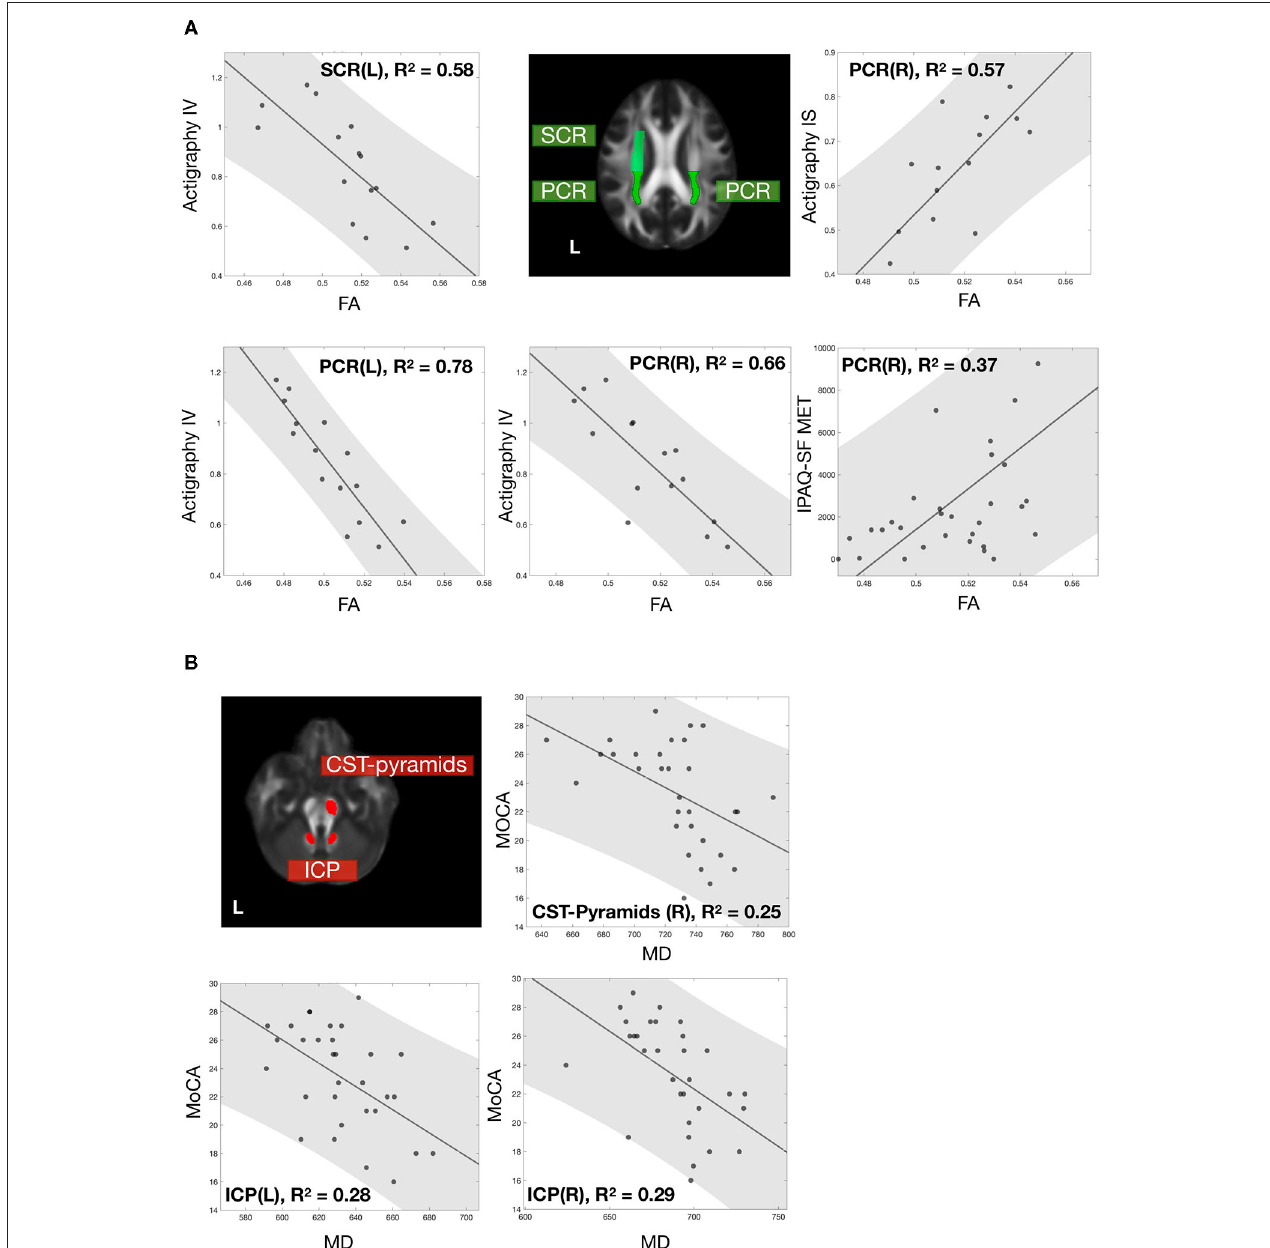
FIGURE 4 | Correlations of white matter microstructure with physical activity and cognitive performance. The correlation between white matter microstructure and (A) physical activity and (B) cognitive performance. All data points were labeled in black dots, with a gray fitting line and a gray patch represent the 95% confidence interval. White matter tracts significantly correlated with physical activity and cognition and were labeled with green and red. All the correlations were significant with FDR-corrected p < 0.05. Noted that 15 participants who completed 72-h recording had actigraphy information; other assessments included all 31